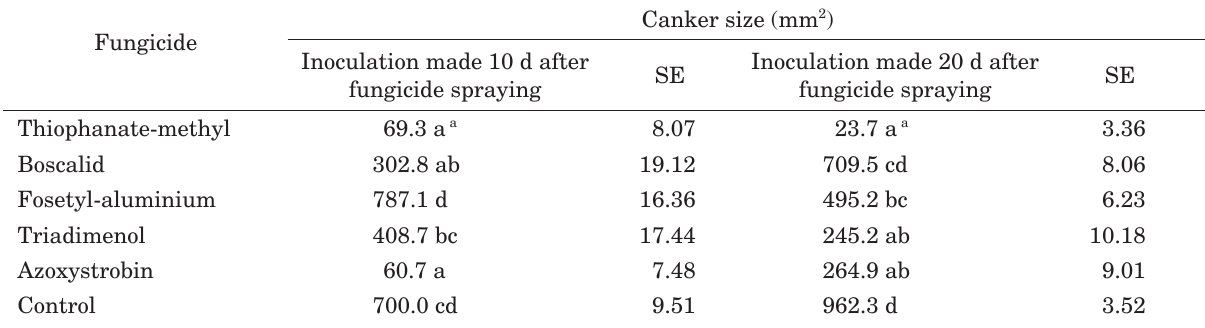
Table 4. Pre-inoculation spraying. Mean area of cankers on the stems of Cupressus sempervirens saplings 4 months after inoculation with Seiridium cardinale . Plants were sprayed with fungicides 10 or 20 days before being pathogen- inoculated. Mean values with different letters within each column were significantly different ( P <0.01) according to the AnOVA one-way HSD